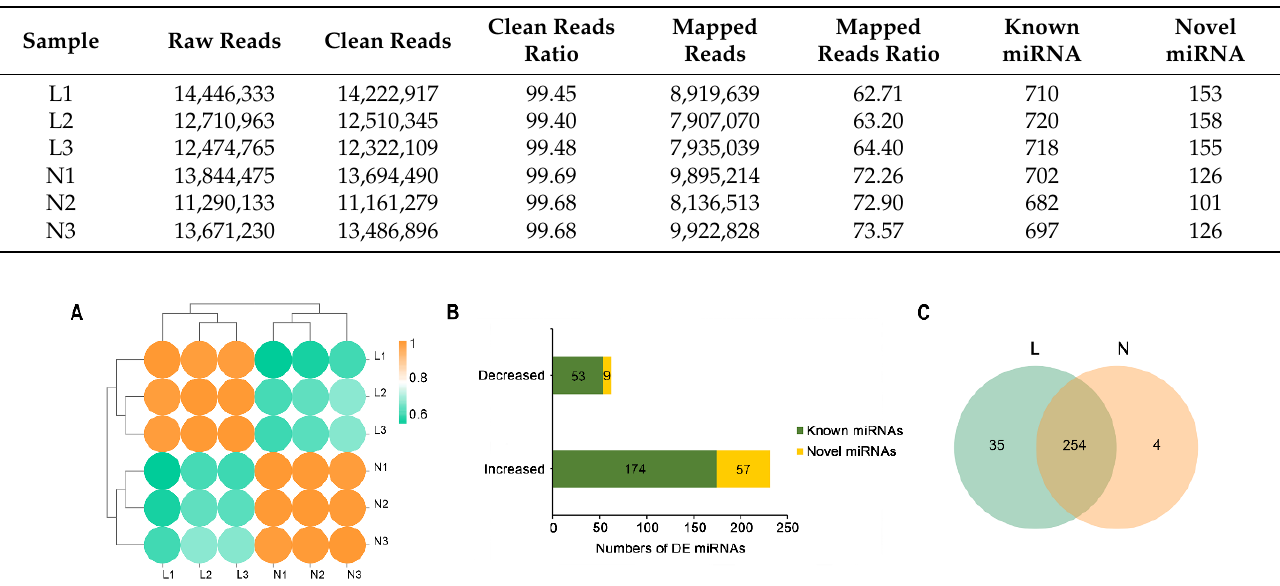
Table 2. Overview of the reads and quality control of the miRNA sequencing libraries from jenny mammary glands.